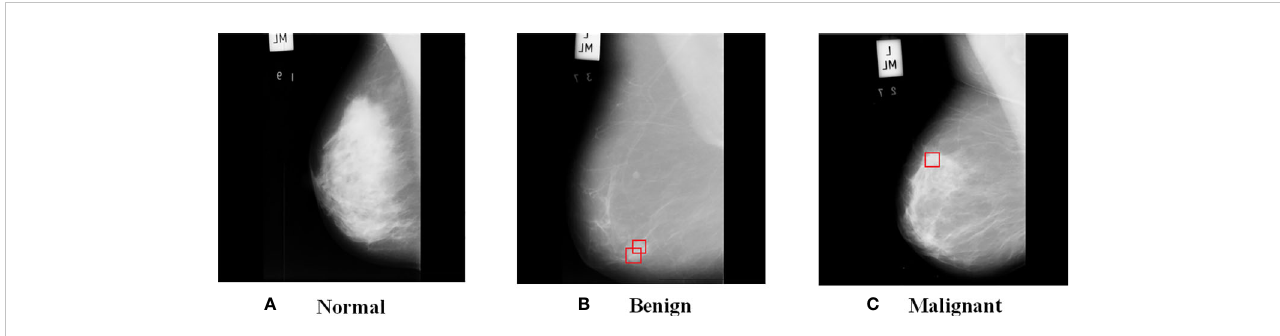
FIGURE 2 Different types of images in MIAS dataset. (A) Normal; (B) Benign; (C) Malignant.